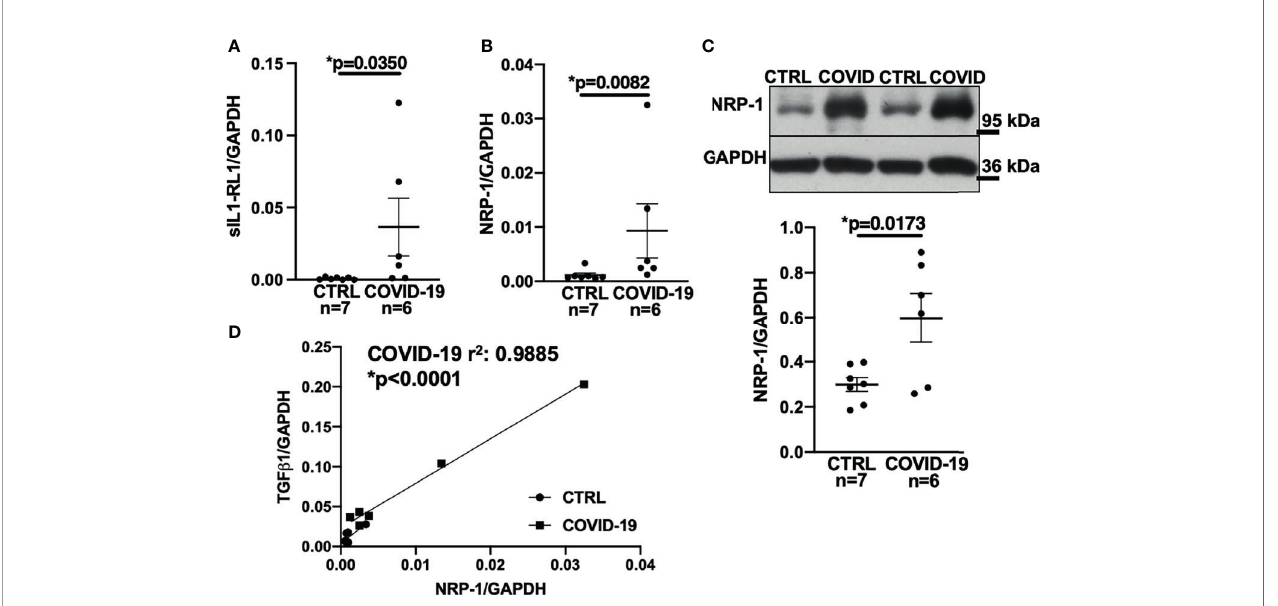
FIGURE 3 | Expression of NRP-1 was signi fi cantly increased in the left ventricular myocardium of deceased COVID-19 patients and correlates with TGF- b 1 mRNA levels. (A) Mean ± SEM mRNA levels (qPCR) of soluble interleukin-1 receptor-like 1 (sIL1-RL1) shows increased expression in left ventricular myocardium of deceased COVID-19 patients (Mann-Whitney test). (B, C) Mean ± SEM NRP-1 mRNA (B) and protein expression ( C, original immunoblot in upper panel). Compared to CTRL, NRP-1 expression was signi fi cantly increased in the left ventricular myocardium of deceased COVID-19 patients both at mRNA (Mann-Whitney) and protein level (Student ’ s t-test). (D) Correlation analysis of left ventricular mRNA expression of TGF- b 1 and NRP-1 (line indicates linear regression). There was a strong and signi fi cant correlation between NRP-1 and TGF- b 1